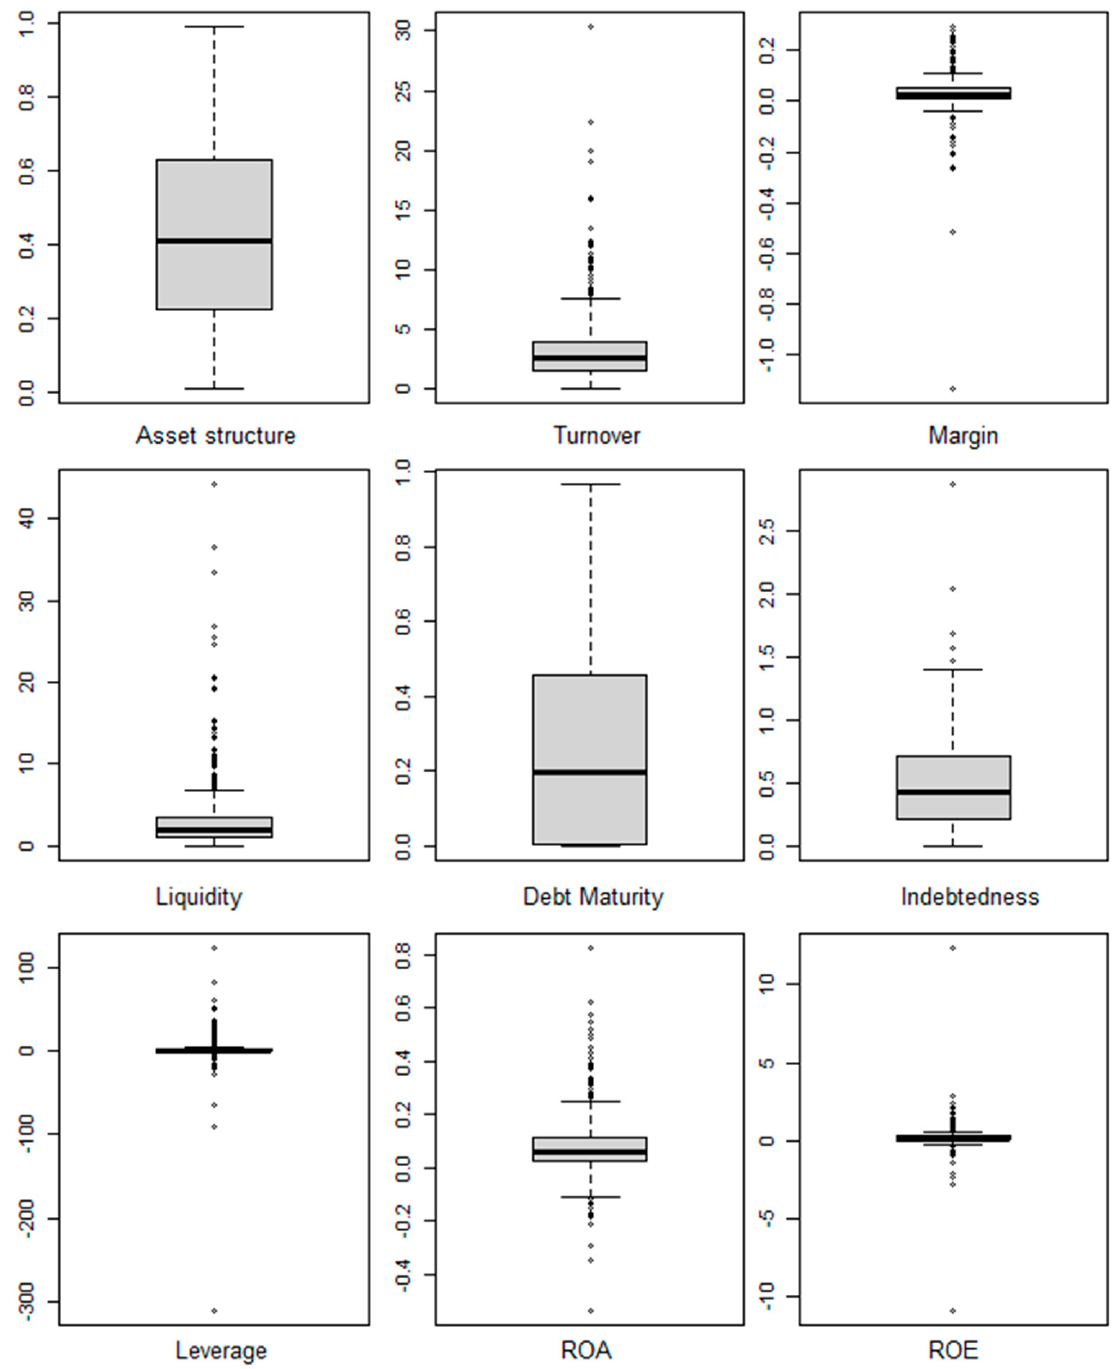
Figure 1. Boxplots of the standard financial ratios.